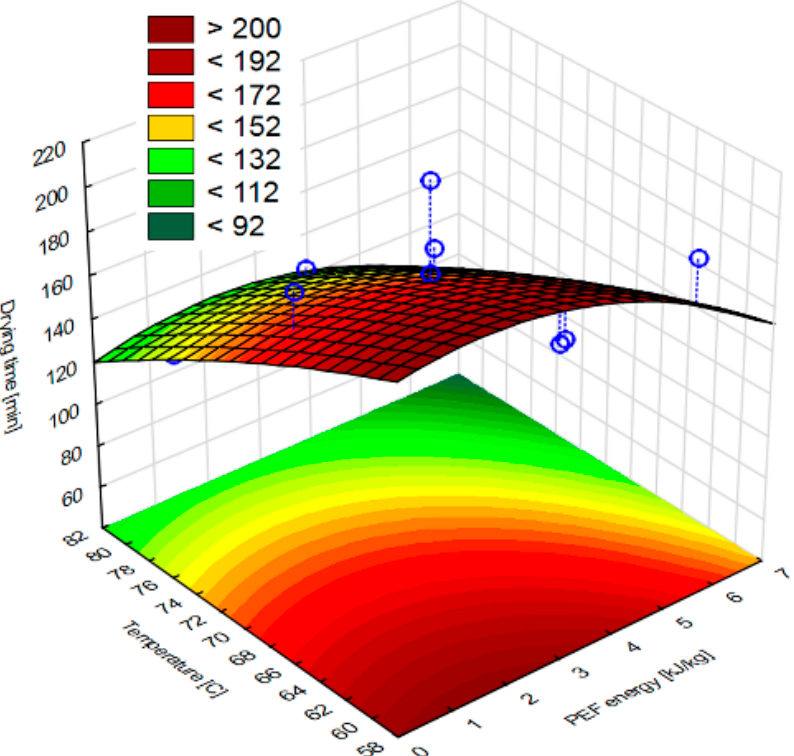
Figure 2. Response surface results for drying time, depending on the pulsed electric field intensity and the temperature obtained in the case of apple tissue subjected to PEF pretreatments with different electric field intensities (1, 3.5, 6 kJ/kg) and hot air drying at different temperatures (60, 70 and 80 ◦ C). Experimental values are marked with points. Table 1. Properties of the fresh apple